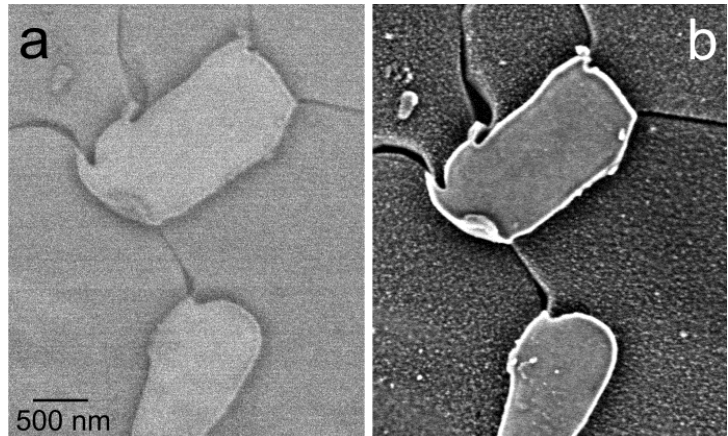
Figure 2. Mg Al precipitates in the AZ91 alloy: ( a ) Standard imaging with backscattered 17 12 electron (BSE) acquired between polar angles 10  and 45  ; ( b ) Sample immersed in 450 V/mm field, polar angles 13  to 63  acquired. Landing energy is 2 keV for both frames.